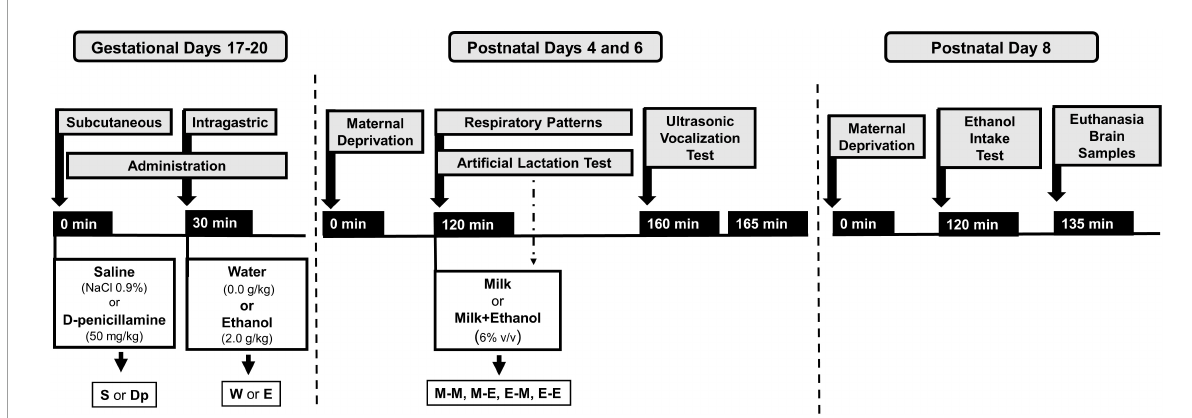
FIGURE1 Experimental procedures performed during gestational days 17–20 and postnatal days 4 and 6. The information provided here describes drug treatments during gestation (administration: saline or D -penicillamine; water or ethanol), postnatal daily temporal course concerning maternal isolation (120 min), postnatal assessments: a 40-min long artificial lactation test and respiratory patterns recording simultaneously followed by 5-min ultrasonic vocalization test. During artificial lactation tests, animals received intraoral infusion of milk (M) or milk mixed with ethanol (E). Four groups were defined as a result of these interventions: M-M, M-E, E-M, and E-E. Overall, 16 groups were defined as a function of prior drug treatment during late gestation and postnatally. For more details, please see section of “Materials and